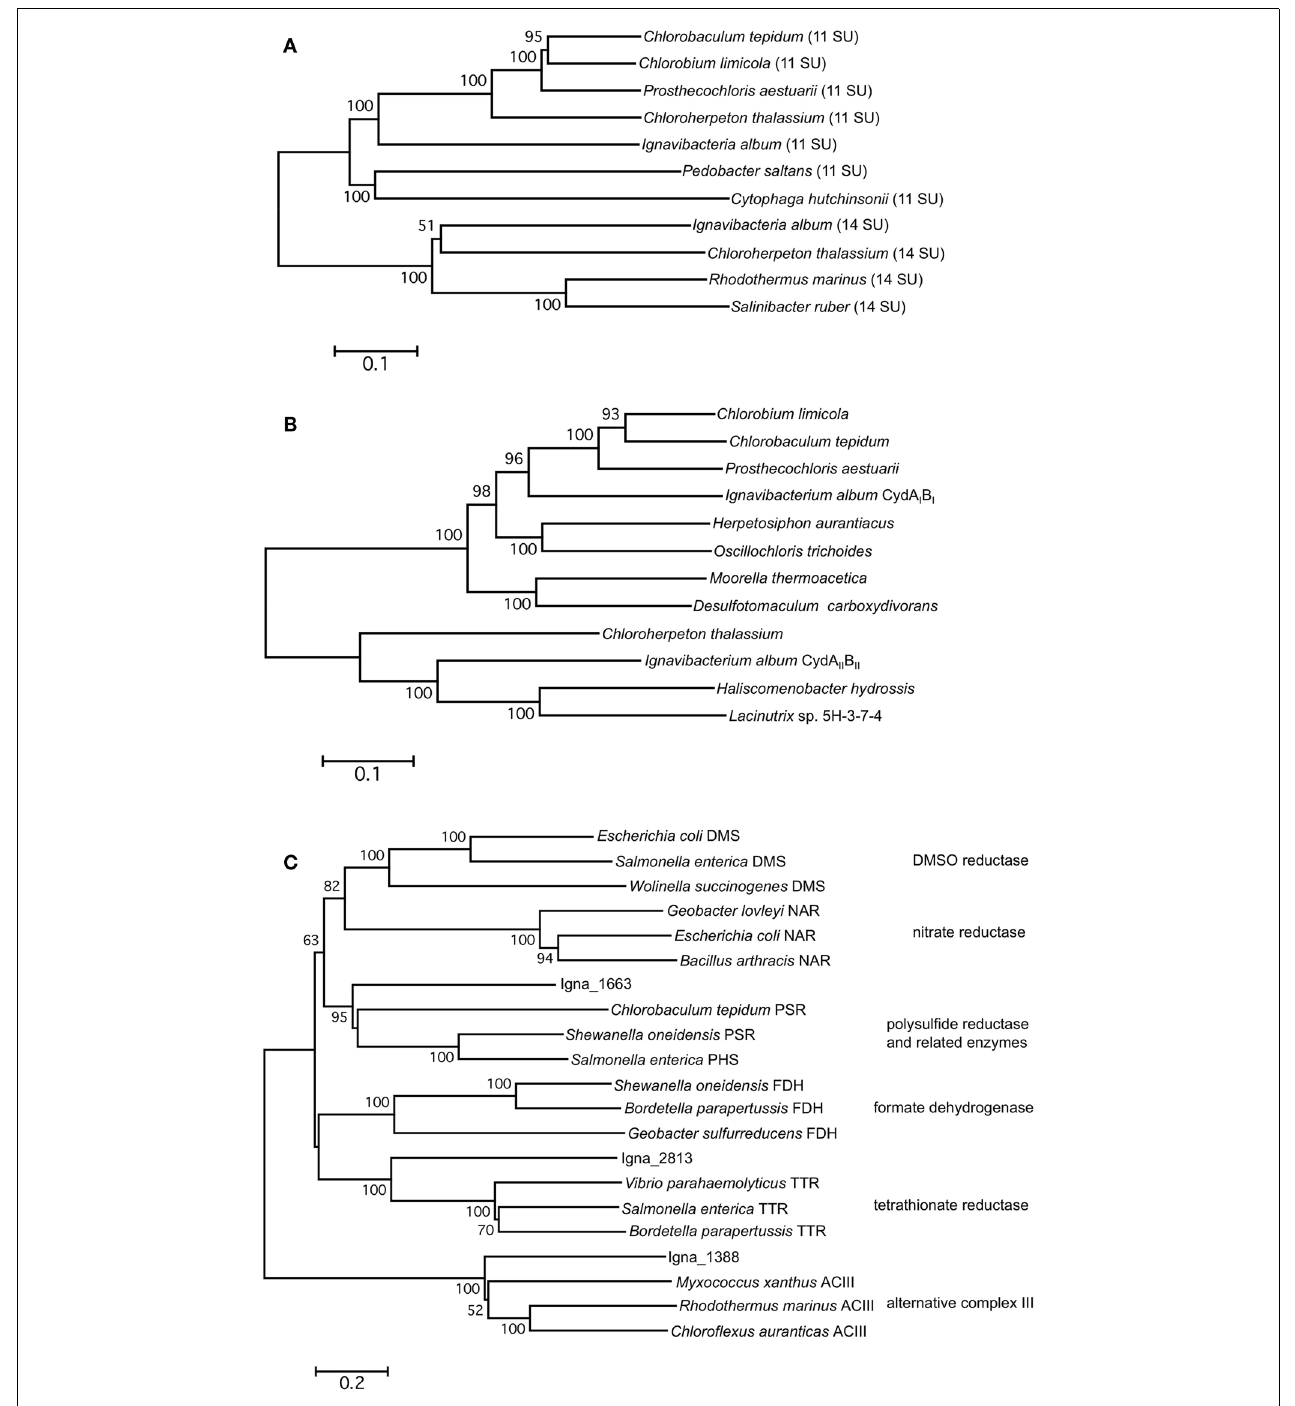
sequences were used for (C) .Trees were created using the neighbor-joining algorithm from 100 bootstrap samplings. Bootstrap support values over 50% are shown. Scale bars denote X changes per amino acid where X is the number above bars. SU, subunits. (C) was adapted fromYanyushin et al. (2005) and was recreated by including I. album